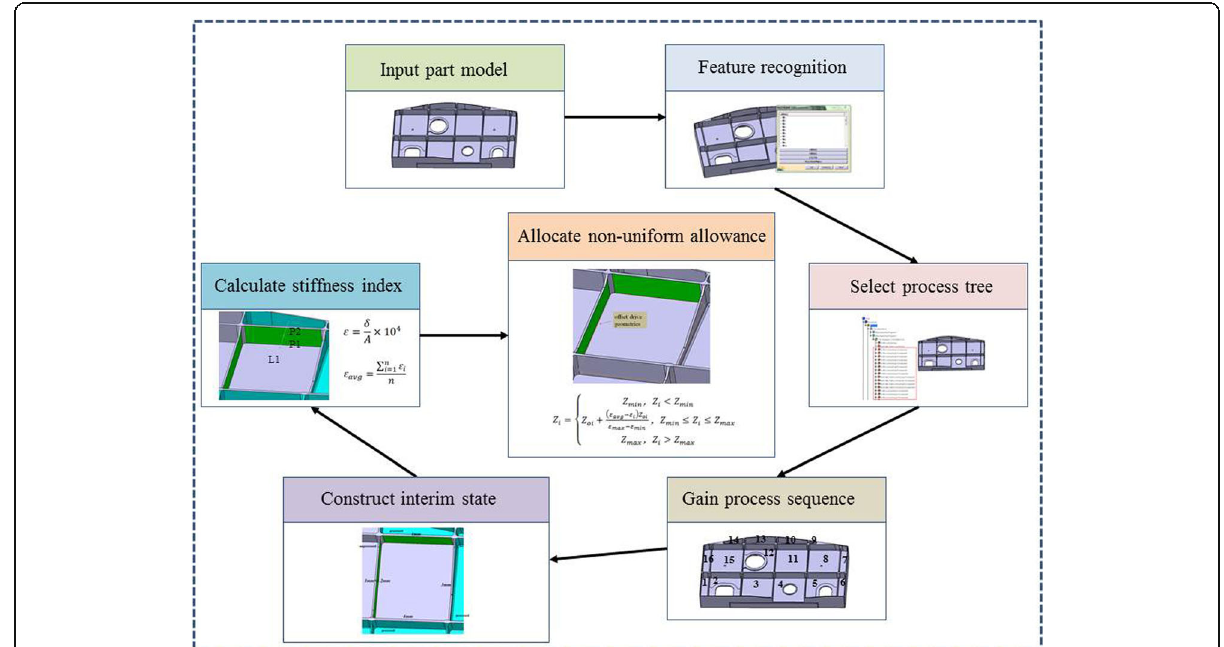
Fig. 7 Process of non-uniform allowance